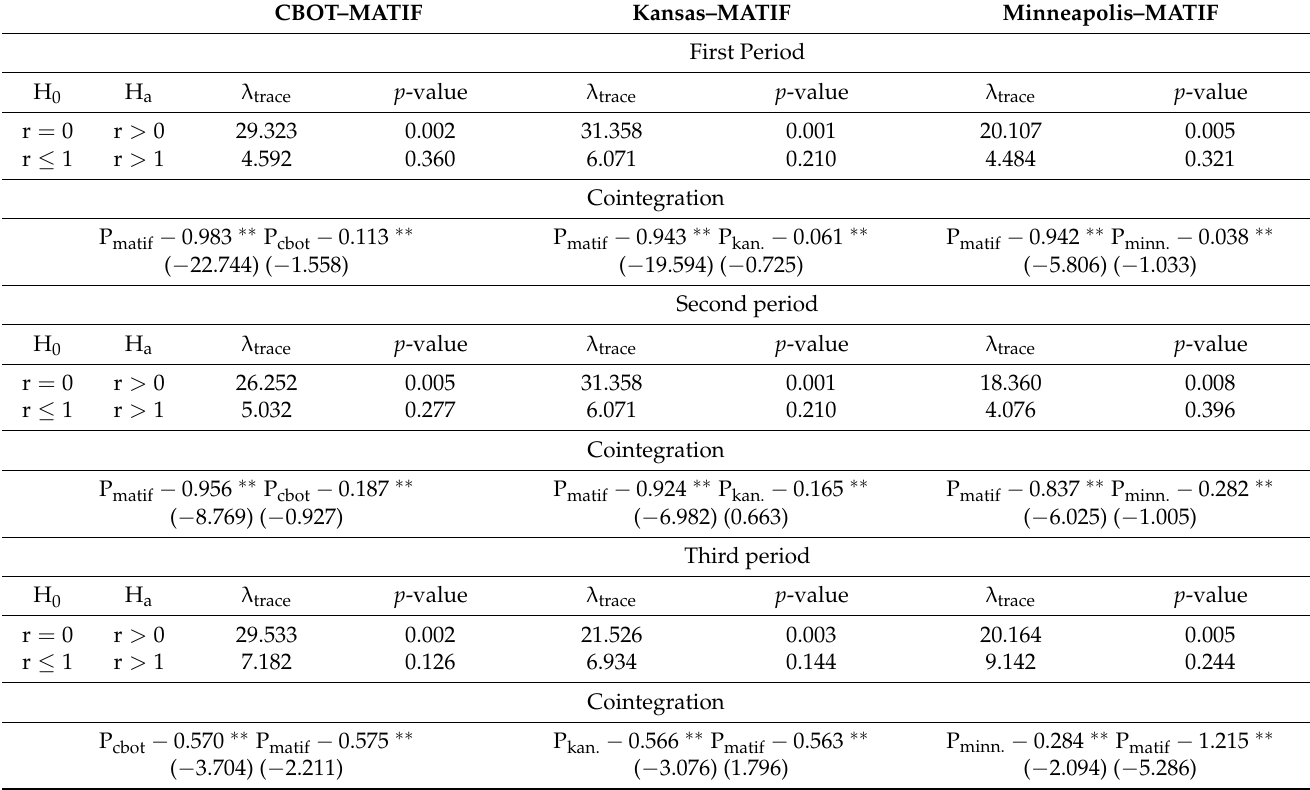
Table 3. Johansen λ trace test for cointegration and cointegration relationship.